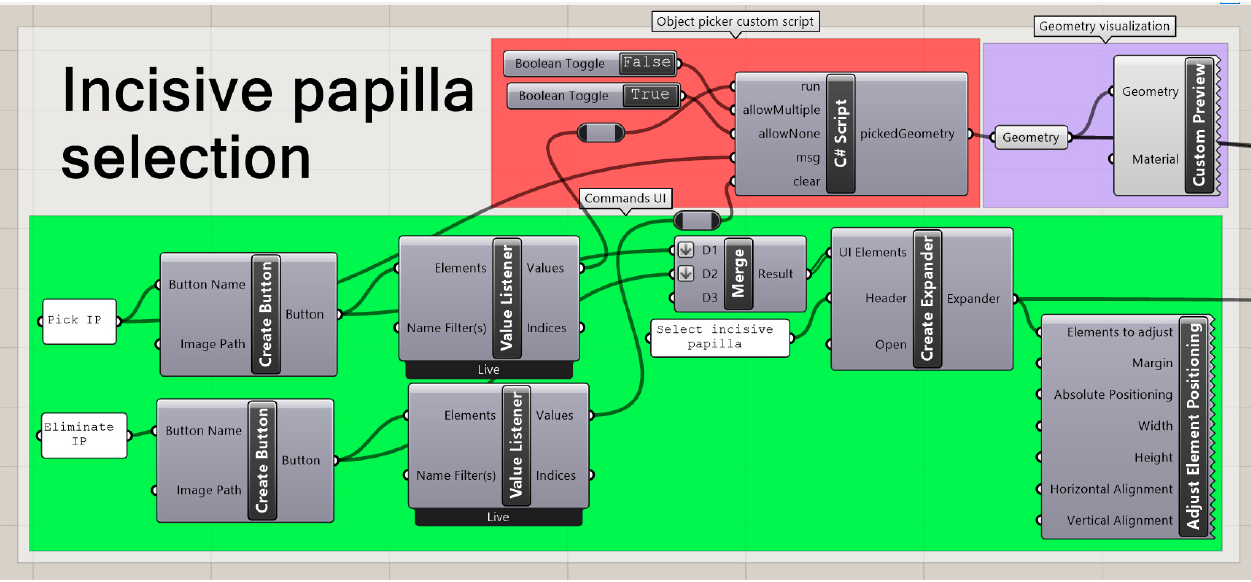
Figure 8. GH code for selection of a point within the measured part. Background colour coding: UI commands (green), conventional GH commands (purple), custom script (red).